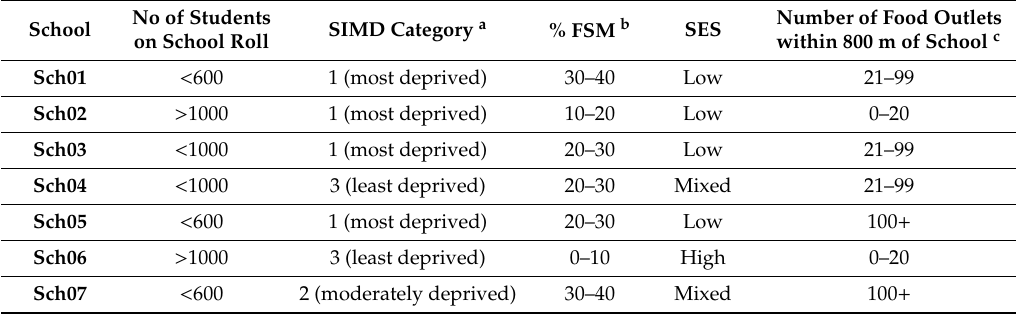
Table 2. Participating schools’ information.